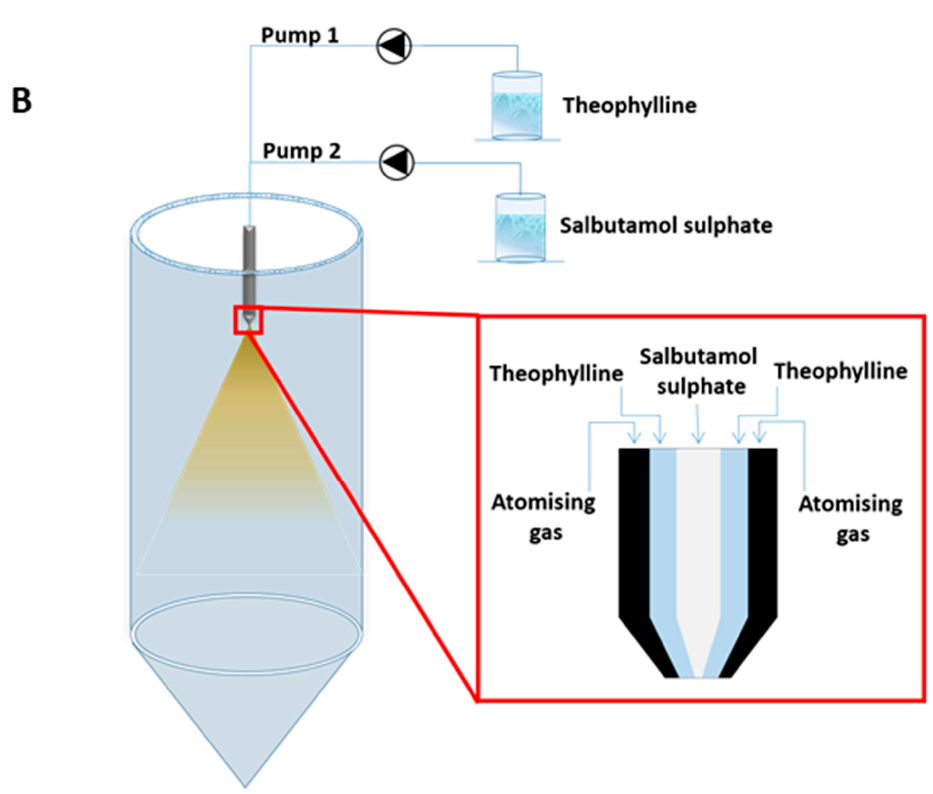
Figure 1. Schematic representation of ( A ) the two-fluid nozzle and ( B ) the three-fluid nozzle.